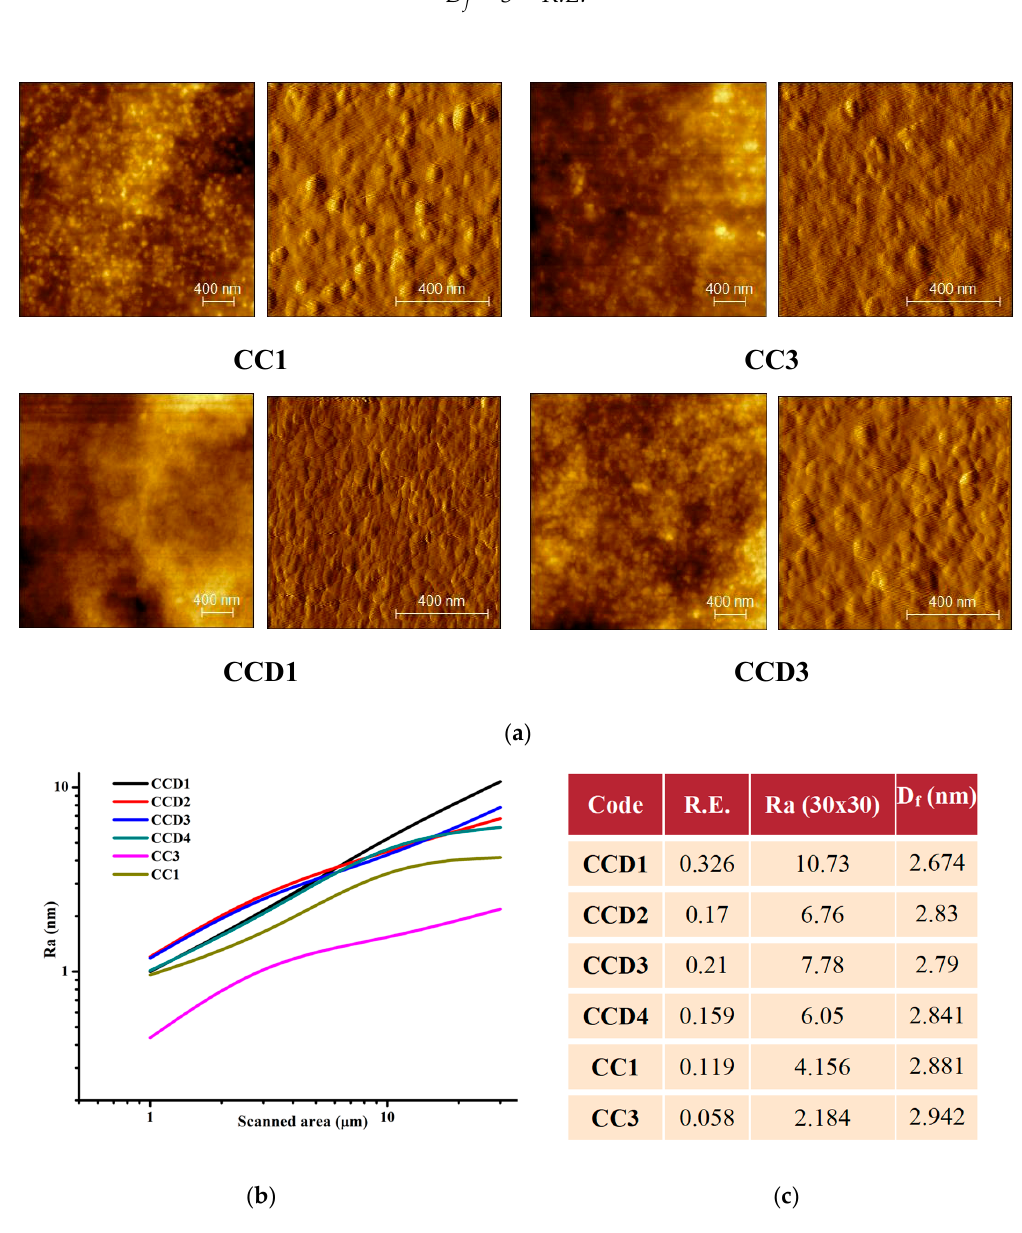
Figure 4. ( a ) Atomic force microscopy (AFM) images of CCD1 and CCD3 drug delivery systems and CC1 and CC3 reference xerogels; ( b ) graphical representation of roughness vs. scan size; and ( c ) the obtained values for the roughness exponent (R.E.), average roughness (Ra), and fractal dimension (Df) for the CCD1-CCD4 drug delivery systems and two reference xerogels CC1 and CC3 . Therefore, all of the investigated samples, reference xerogels, and drug delivery systems presented values of the fractal dimension close to 3, revealing that the surface of the samples looks